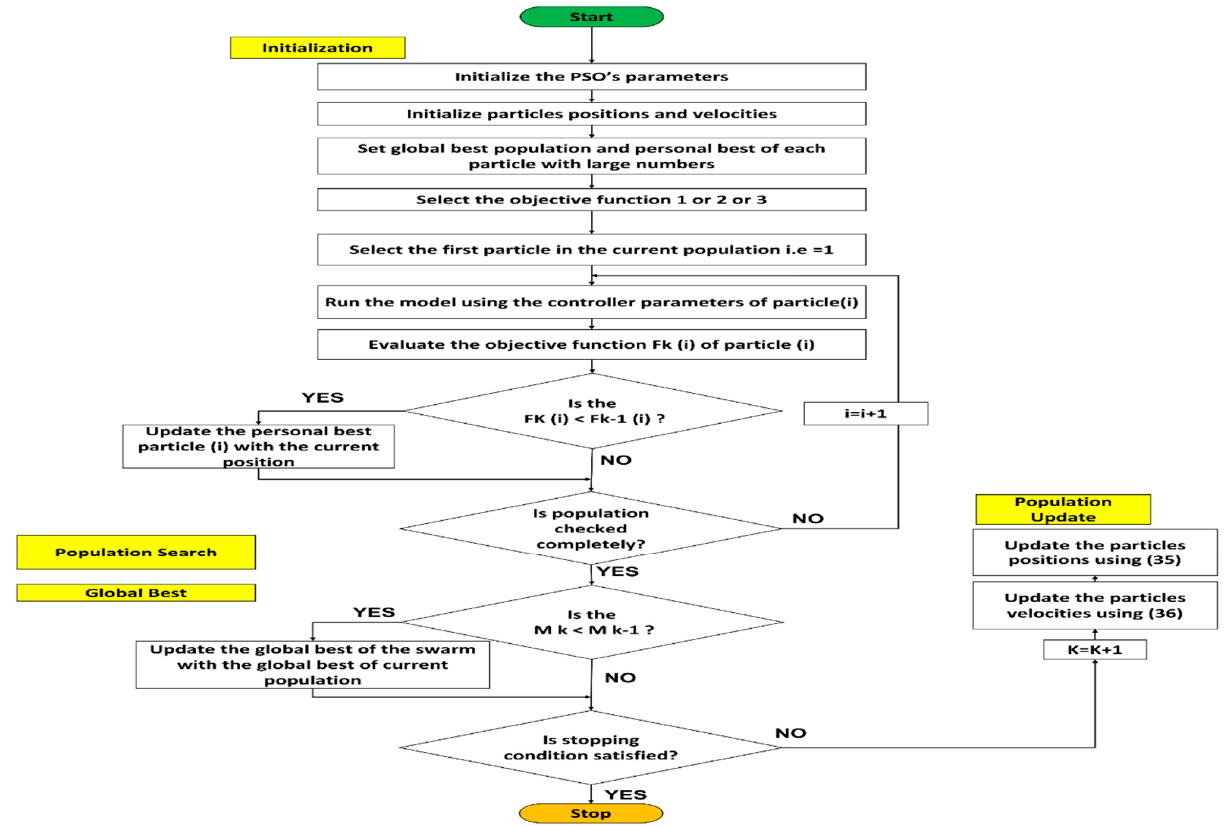
Figure 11. PSO algorithm flowchart.